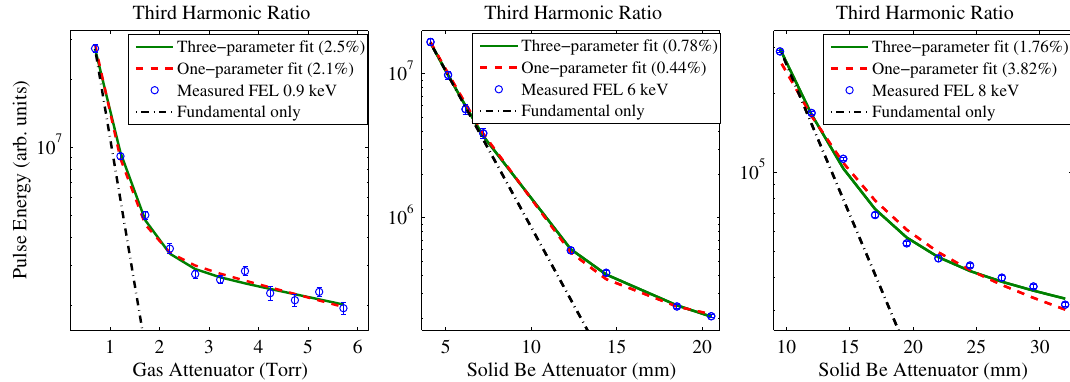
FIG. 4. Examples of third harmonic measurements for fundamental FEL photon energies of 0.9 keV (left), 6 keV (center), and 8 keV (right). Blue circles show the experimental data, red dotted lines show linear one-parameter fits using the nominal attenuation lengths, while solid green lines show three-parameter fits to both the harmonic content and attenuation lengths. The black dot-dashed line shows the expected drop in intensity for the fundamental only. We typically find around 2% third harmonic for soft x rays, with between 0.2%–2% third harmonic at hard x rays. The 4% level found from the one-parameter fit at 8 keV (right plot) is higher than expected, and may be artificially high due to a lack of measurement points dominated by the fundamental.